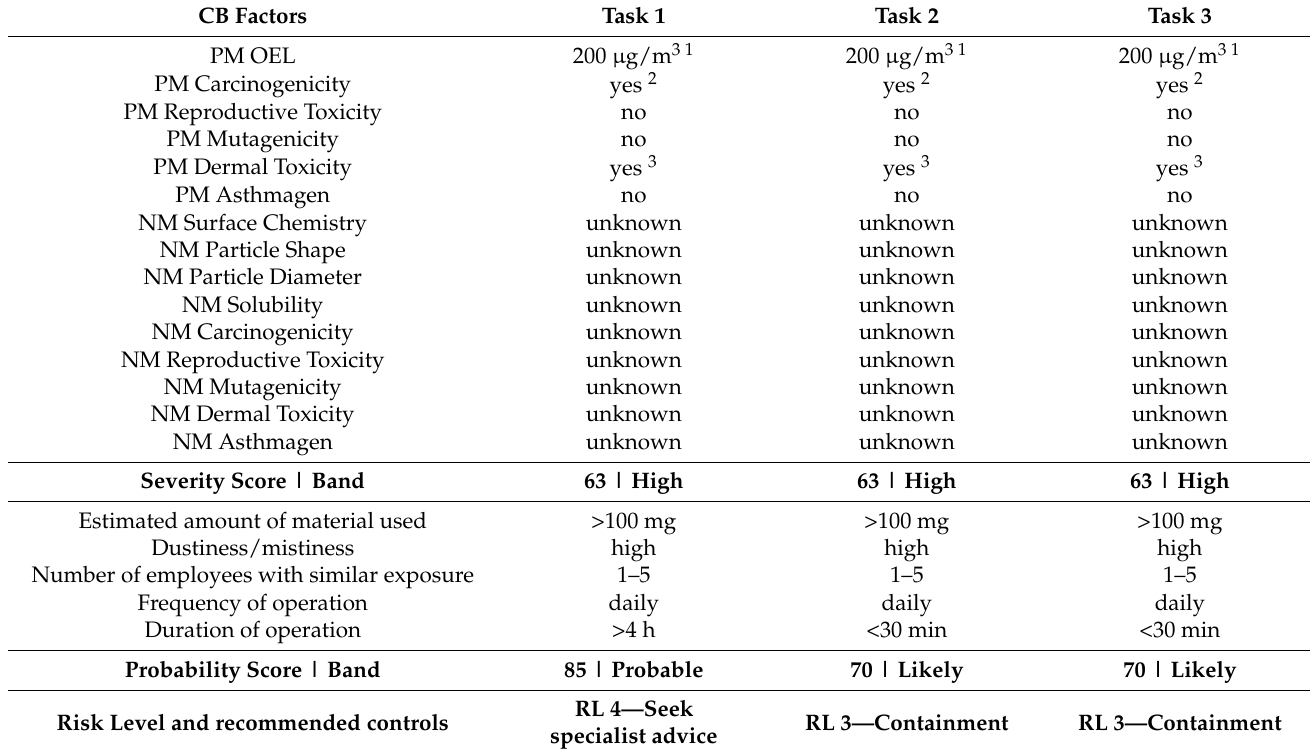
Table 5. Results of the application of CB Nanotool version